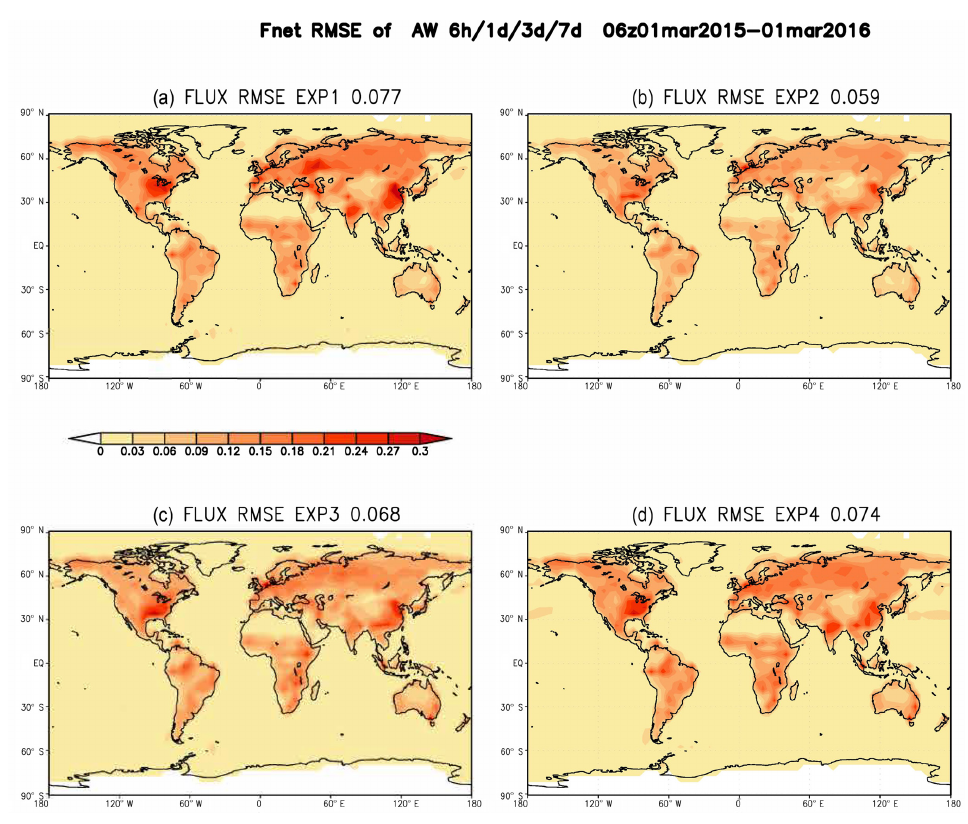
Figure 3. The spatial pattern of the annual mean RMSE of estimated SCF from the experiments with different AW (EXP1–4) for the average period from 1 March 2015 to the end of February 2016. (January and February 2015 are treated as a spin-up period for our